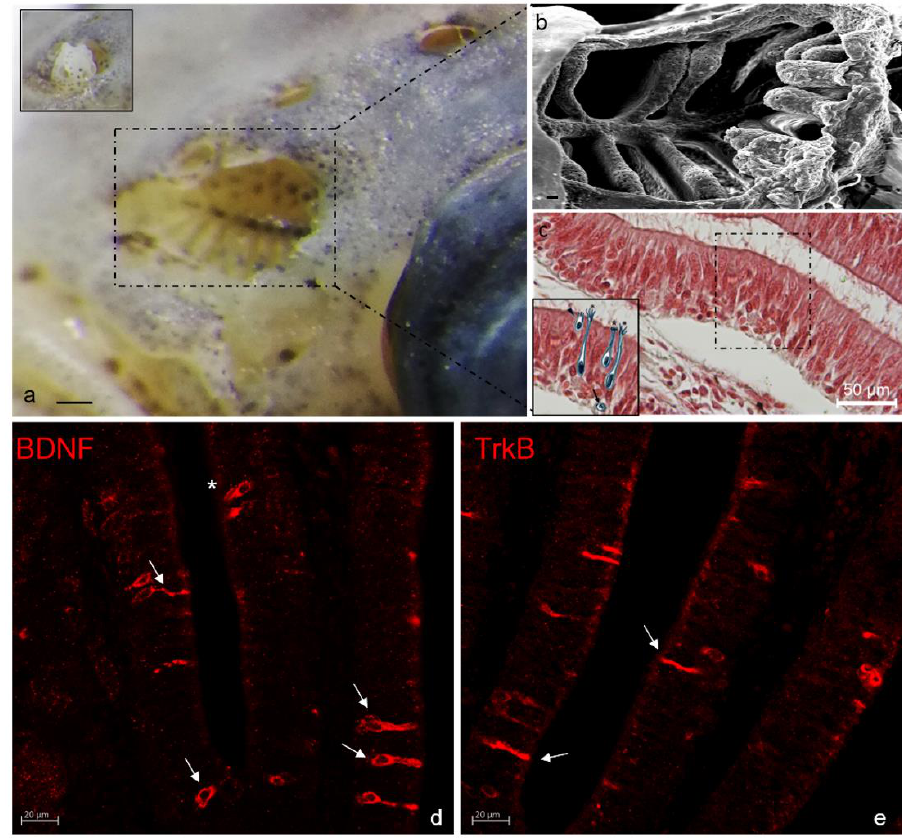
Figure 4. Stereomicrograph of zebrafish nose after removing nostril cartilage ( a , insert); olfactory epithelium is visible ( a , dashed area); Scanning electron micrograph of zebrafish olfactory epithelium organized in lamellae ( b ); Sensory cells (insert) of the olfactory epithelium of the sensory part of the rosette lamella: cryptic neuron (arrowhead), neuron with microvilli (star), ciliate neurons (asterisks), immature neuron (arrow) ( c ); Immunohistochemical localization of BDNF ( d ); and TrkB ( e ) in crypt cells (asterisks) and sensory cells (arrows) in basal and sensory segment of olfactory lamellae. Scale bar: 1mm ( a ), 20 µm ( b ). Magnification 40× ( c – e ).